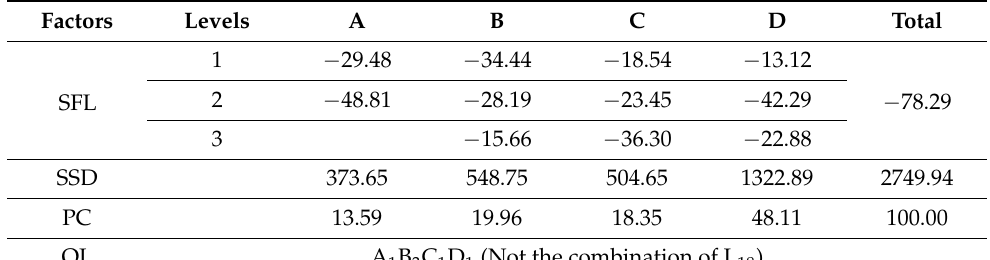
Table 17. Pareto ANOVA for the multi-response—Taguchi-CRITIC-Utility approach. Factors Levels A